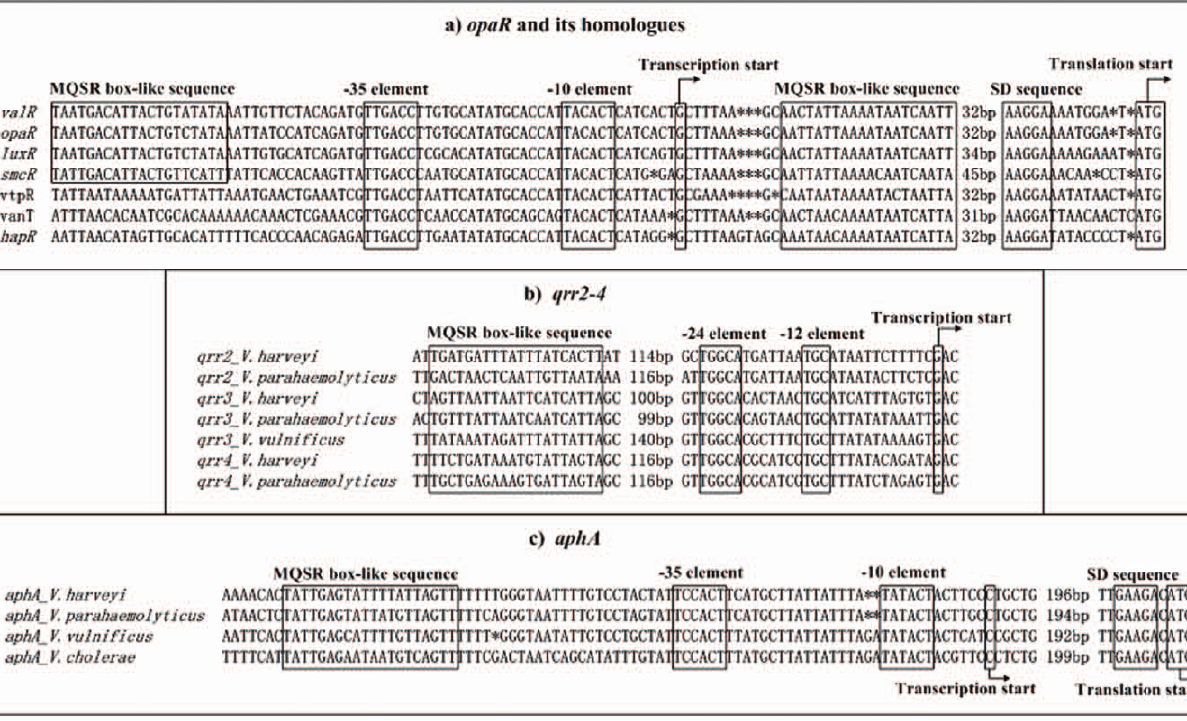
Figure S1 Primer extension assay for validation of non- polar mutation. The opaR null mutant D opaR was generated from the wild-type (WT) strain RIMD 2210633, and then the complemented mutant strain C-opaR was constructed. As deter-